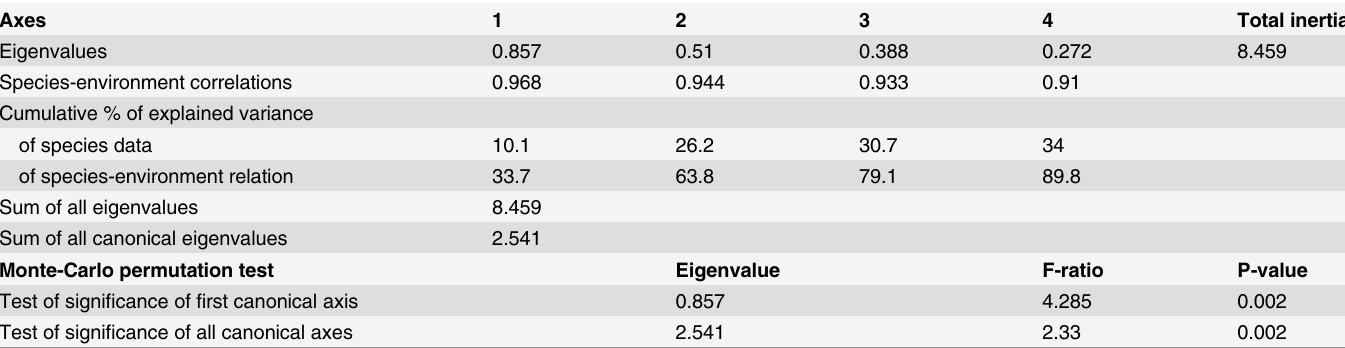
Table 4. Canonical Correspondence Analysis results.